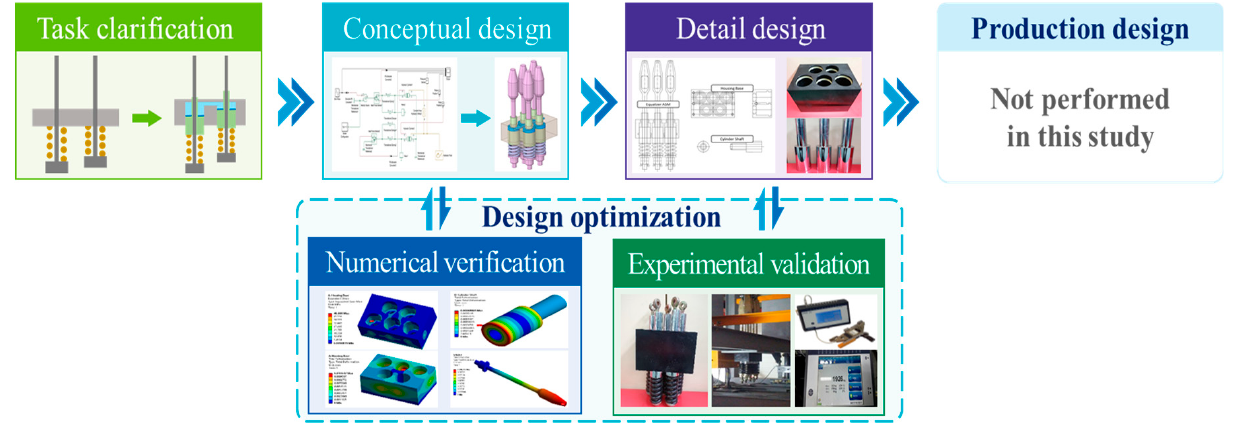
Figure 10. Systematic design process considered in this study.